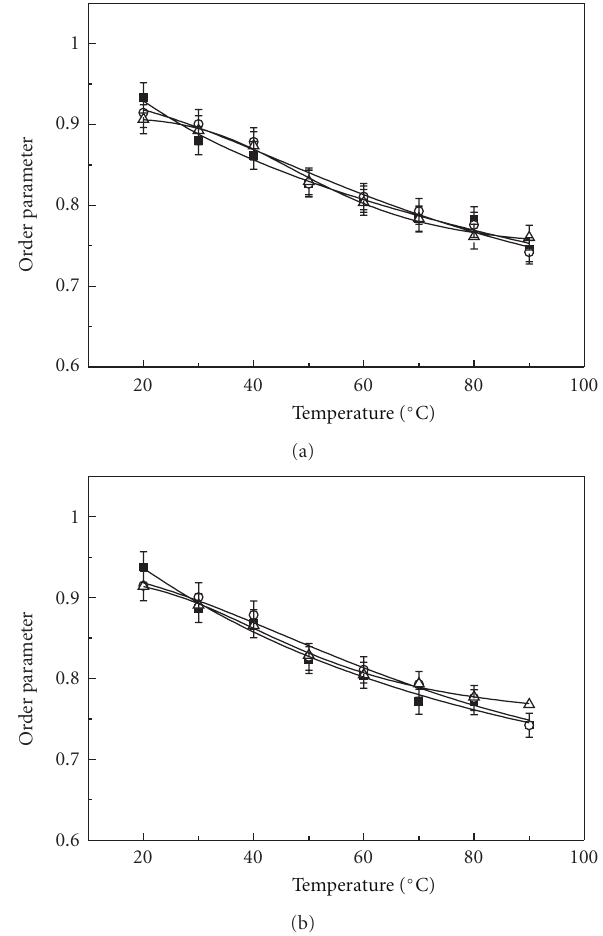
Figure 5: Temperature dependence of the lipid order parameter of the PLMF from A. pernix grown in medium with di ff erent pH ( (cid:2) pH 6.0; (cid:6) pH 7.0; Δ pH 8.0) determined by measuring the anisotropy of TMA-DPH. The lines represent nonlinear curve fitting to the data points. (a) pH of measured samples was the same as the pH of growth medium; (b) experiments were performed at pH 7.0.